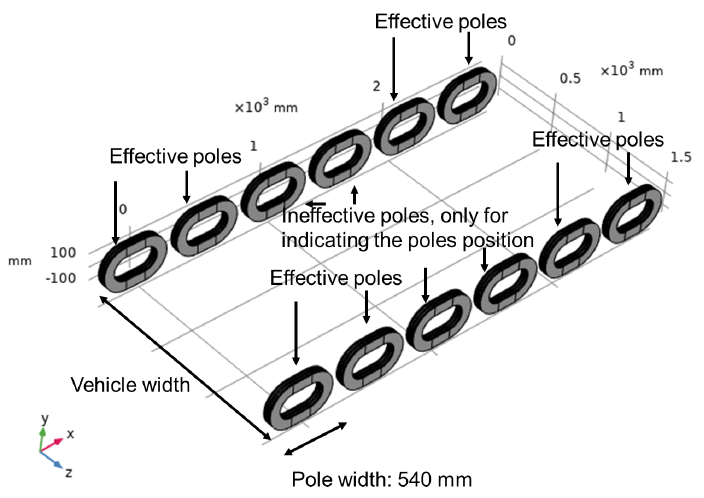
Figure 2. Topology of the HTS poles for the maglev trial vehicle (the four central poles do not exist in actual usage, and the provided topology indicates the positional relationship of the